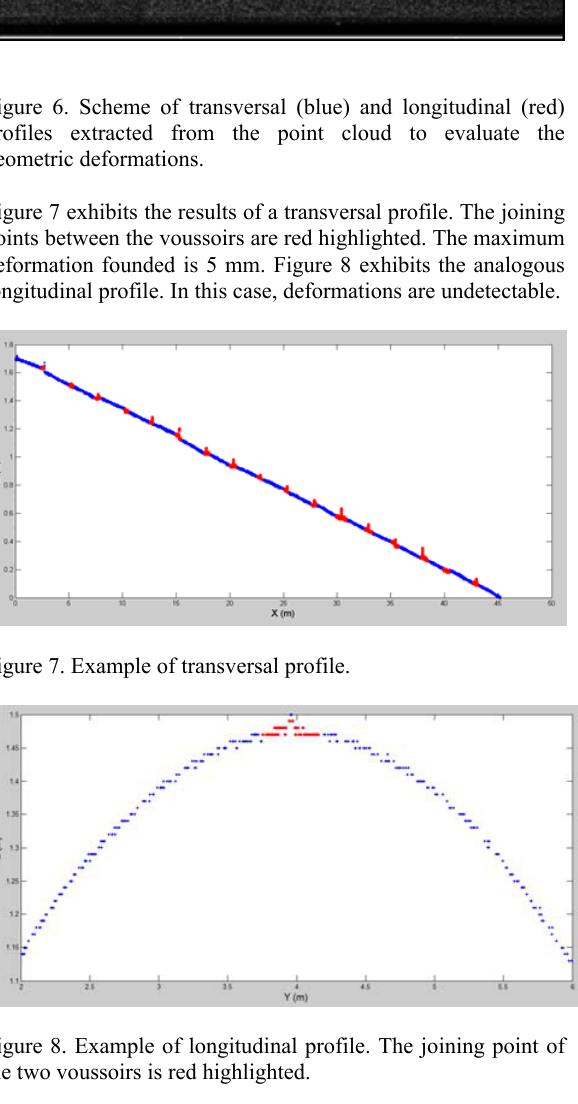
Figure 8. Example of longitudinal profile. The joining point of the two voussoirs is red